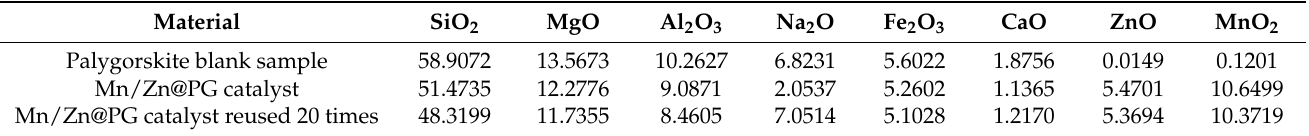
Table 2. XRF characterization results.